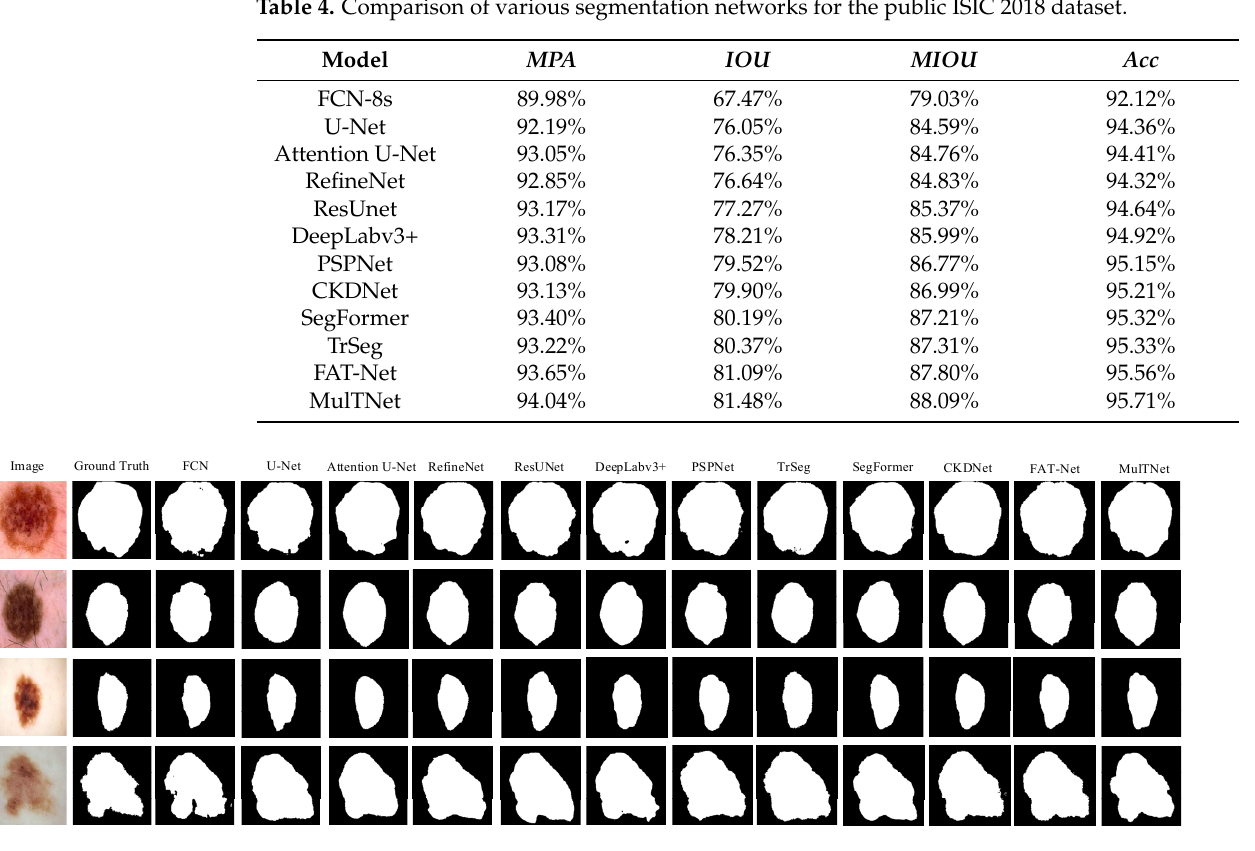
Figure 4. Examples of the marine animal segmentation obtained by FCN-8s, U-Net, Attention U-Net, RefineNet, ResUNet, Deeplabv3+, PSPNet, TrSeg, SegFormer, CKDNet, FAT-Net, and the proposed MulTNet.